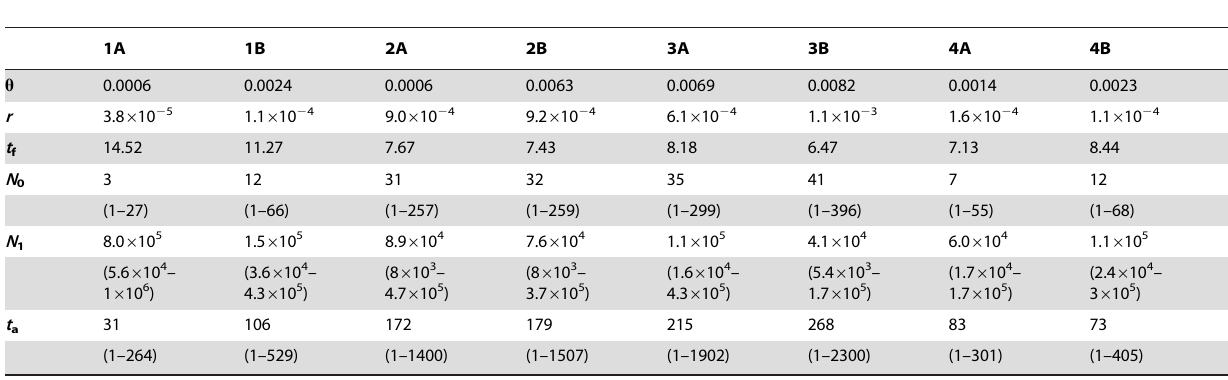
Table 6. Summary statistics of MSVAR across all locations, including the genetic parameter h = 2 N 0 m , which was calculated using a mutation rate of m =10 2 4 , r = N 0 / N 1 ( N 0 =current effective population size; N 1 = effective population size at the time of population expansion or decline), and t f = t a / N 0 ( t a =number of generations since the beginning of the expansion/decline).